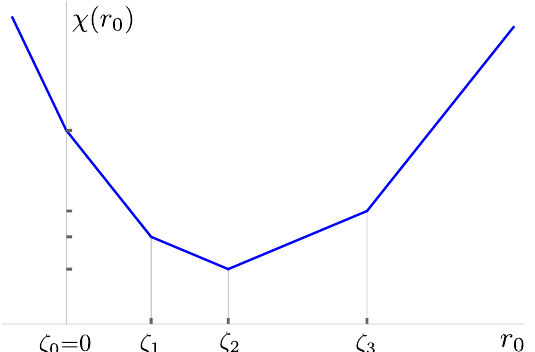
) in the case of the SU ( 4 ) singularity 0 1 and ζ corresponds to a − 1 a